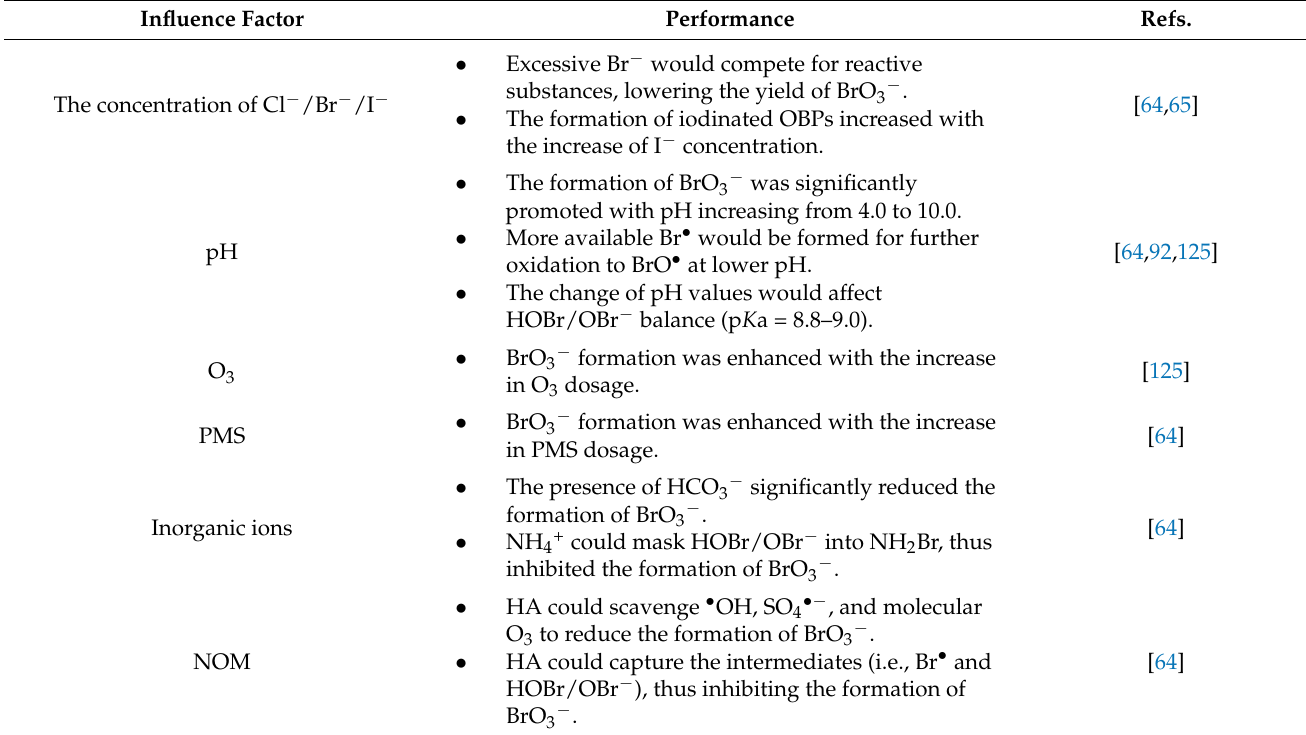
Table 4. The influence of reaction conditions on OBP